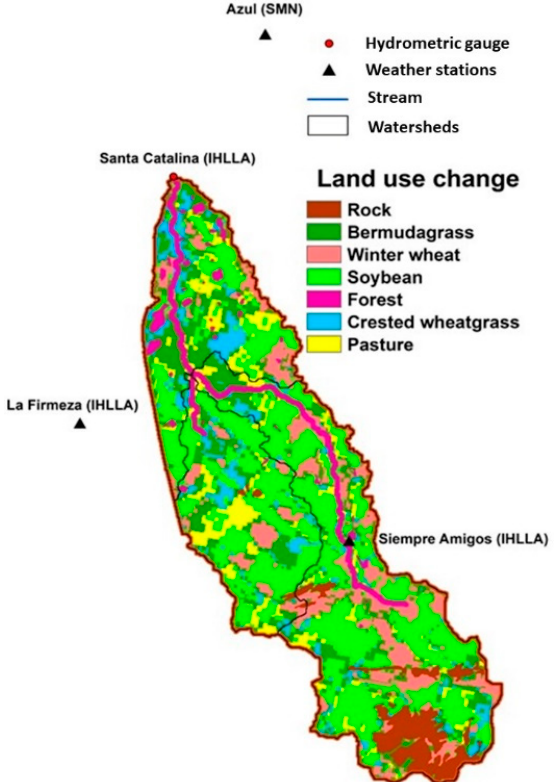
Figure 5. Map of the land use change scenario (SWT1) for the Santa Catalina stream basin used for the SWAT simulation.